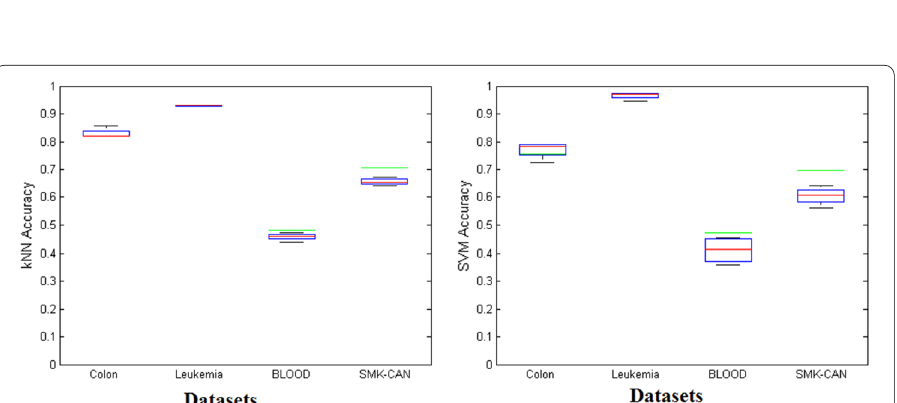
Fig. 9 Accuracy evaluation of Chi square using KNN and SVM. Green line represents bagging while Black Lines, Red line and Blue box represent maximum, minimum, median and quartile of baseline performance respectively